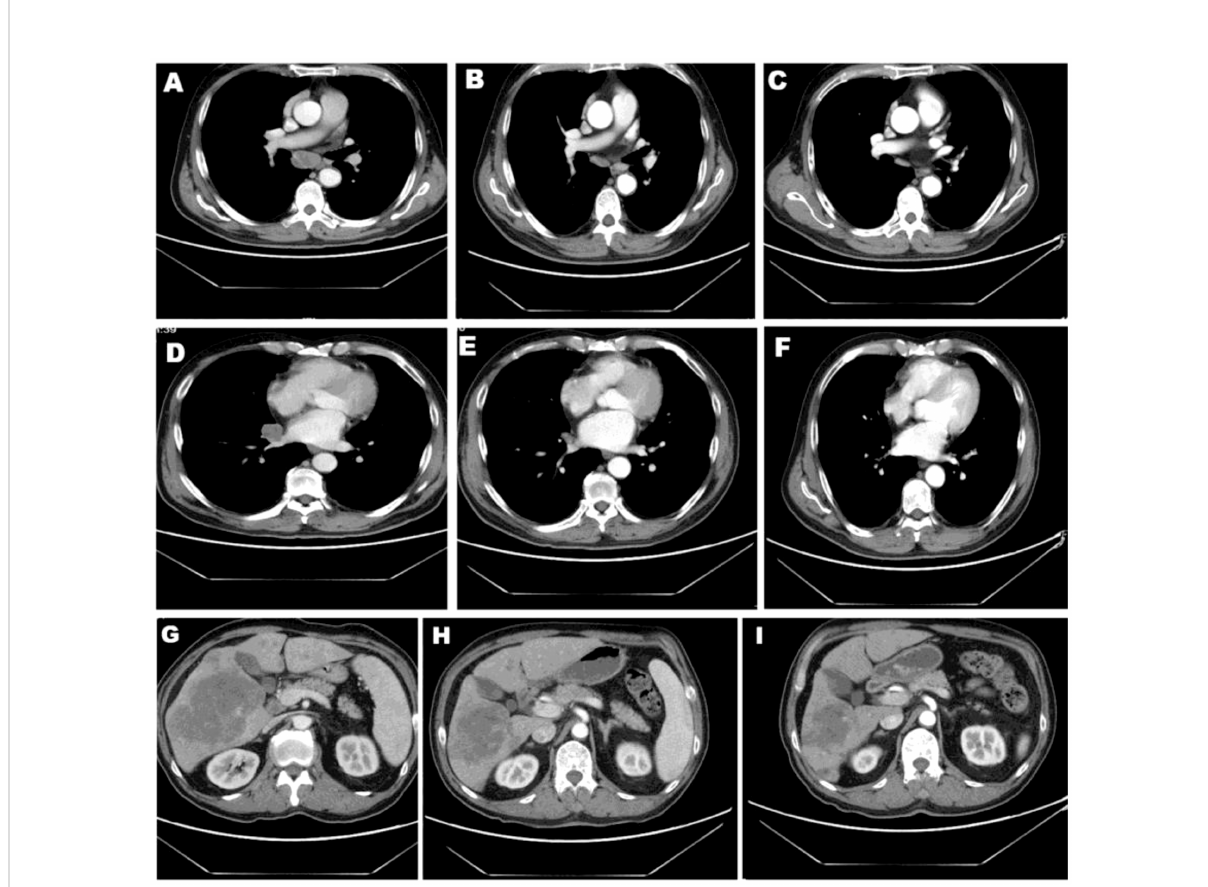
FIGURE 1 Patient CT images. CT scans of lesion 1 (A – C) and lesion 2 (D – F) in lung as well as lesion in liver (G – I) before and after 1 or 2 months of pralsetinib